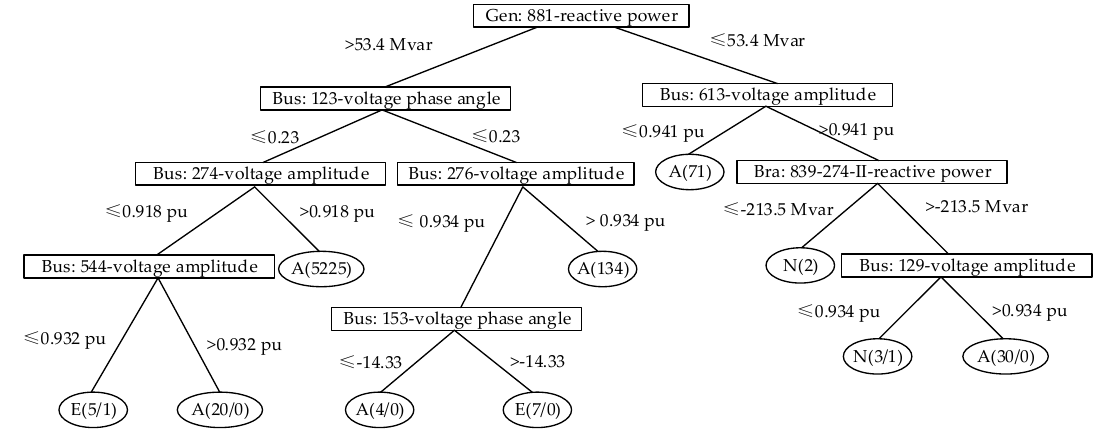
Figure 4. Weight value associated with initial attributes.